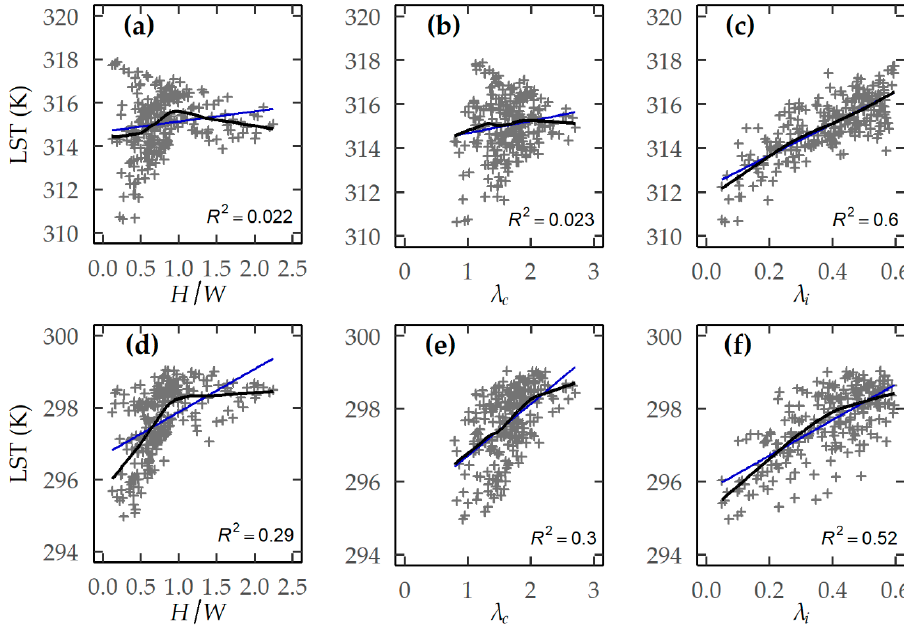
Figure 10. The relationship between H / W , λ c , and λ i for the urban area of Athens: During daytime ( a – c ), and during nighttime ( d – f ). Black curves correspond to the lowess regression lines. Blue lines and R 2 correspond to the linear regression fit.